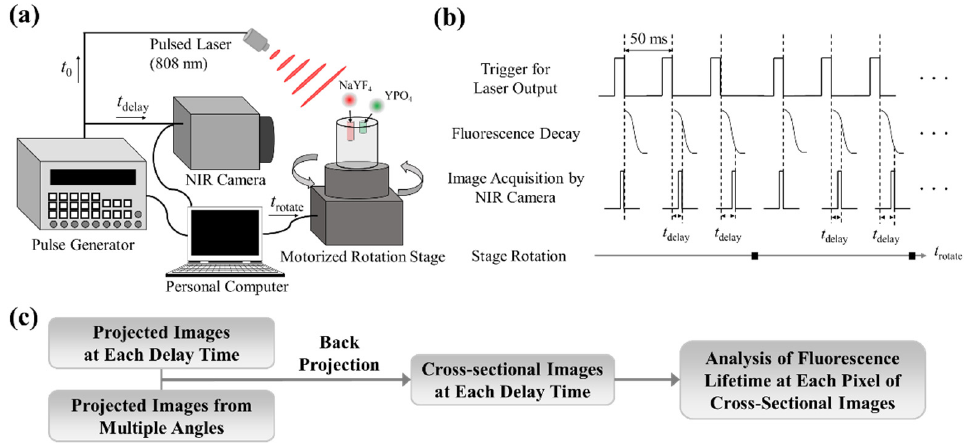
Figure 1. Setup of computed tomography (CT) for near-infrared fluorescence (NIRF) time-gated imaging (TGI). ( a ) Schematic illustration of the system for NIRF-TGI combined with CT. ( b ) Time chart of pulsed irradiation for fluorescence excitation at 808 nm, image acquisition using the NIRF- TGI system and time points when the motorized stage rotates, along with the expected profiles of fluorescence decay. This system can acquire projected images at controlled delay times after turning off the excitation laser to record images of fluorescence decay. The projected images of the fluorescence decay of samples can be collected from multiple angles to control the rotation of the stage. As shown in ( c ) the block diagram of the image acquisition and processing for conducting NIRF-TGI-CT, tomographic images are first reconstructed for each delay time by conventional back- projection. Next, the fluorescence lifetimes can be determined at each pixel of the tomograms obtained at multiple delay